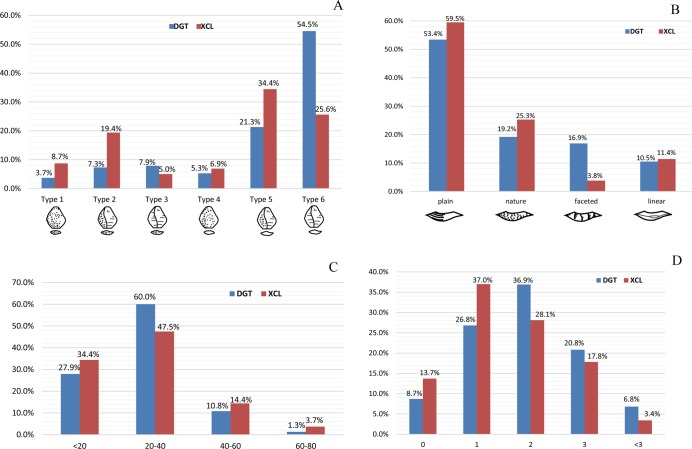
Comparison of DGT and XCL flake attributes.(A) Percentage of cortex on flakes according to Toth’s types [54]; (B) Types of striking platforms on flakes; (C) Flake size ranges (in mm); (D) Number of negative scars on dorsal faces of flakes.